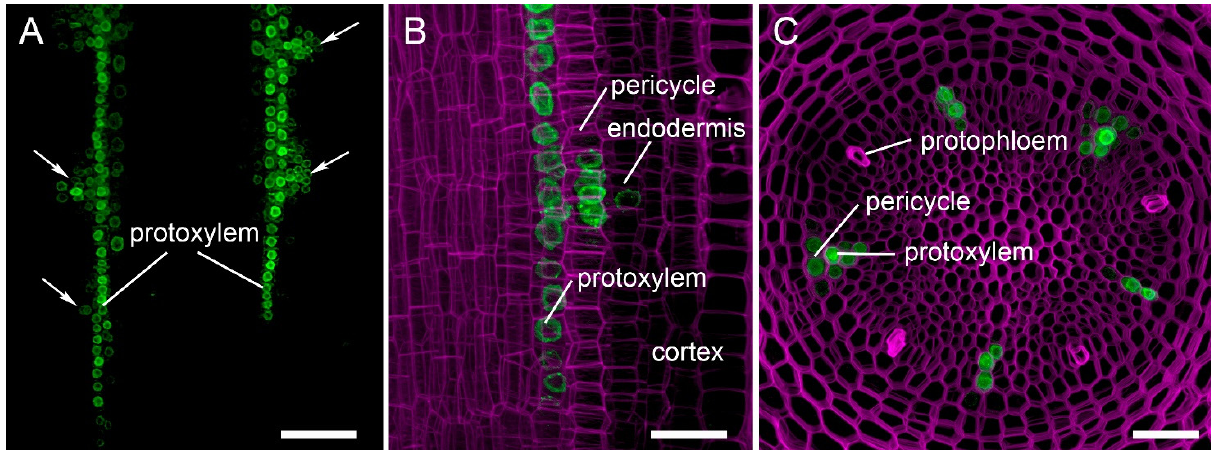
Figure 3. Localization of CsRALF34 expression in a Cucumis sativus root tip. Confocal laser scanning microscopy of vibratome longitudinal ( A , B ) and cross ( C ) sections of transgenic pCsRALF34::mNeonGreen-H2B roots. Green channel—fluorescence of mNeonGreen-H2B; magenta channel—cell walls are counter stained with SCRI Renaissance 2200. ( A ) An overview and ( B ) close- up of the parental root meristem shows the acropetal sequence of CsRALF34 promoter activity in protoxylem, pericycle and endodermis. CsRALF34 expression arises first in the protoxylem at a distance of 150 µm from the initial cells. ( C ) The establishment of activity in xylem, pericycle layers and endodermis on a cross section at a distance of 300 µm from the initial cells. Arrows indicate developing lateral root primordia. Scale bars: 100 µm in ( A ), and 40 µm in ( B , C ).